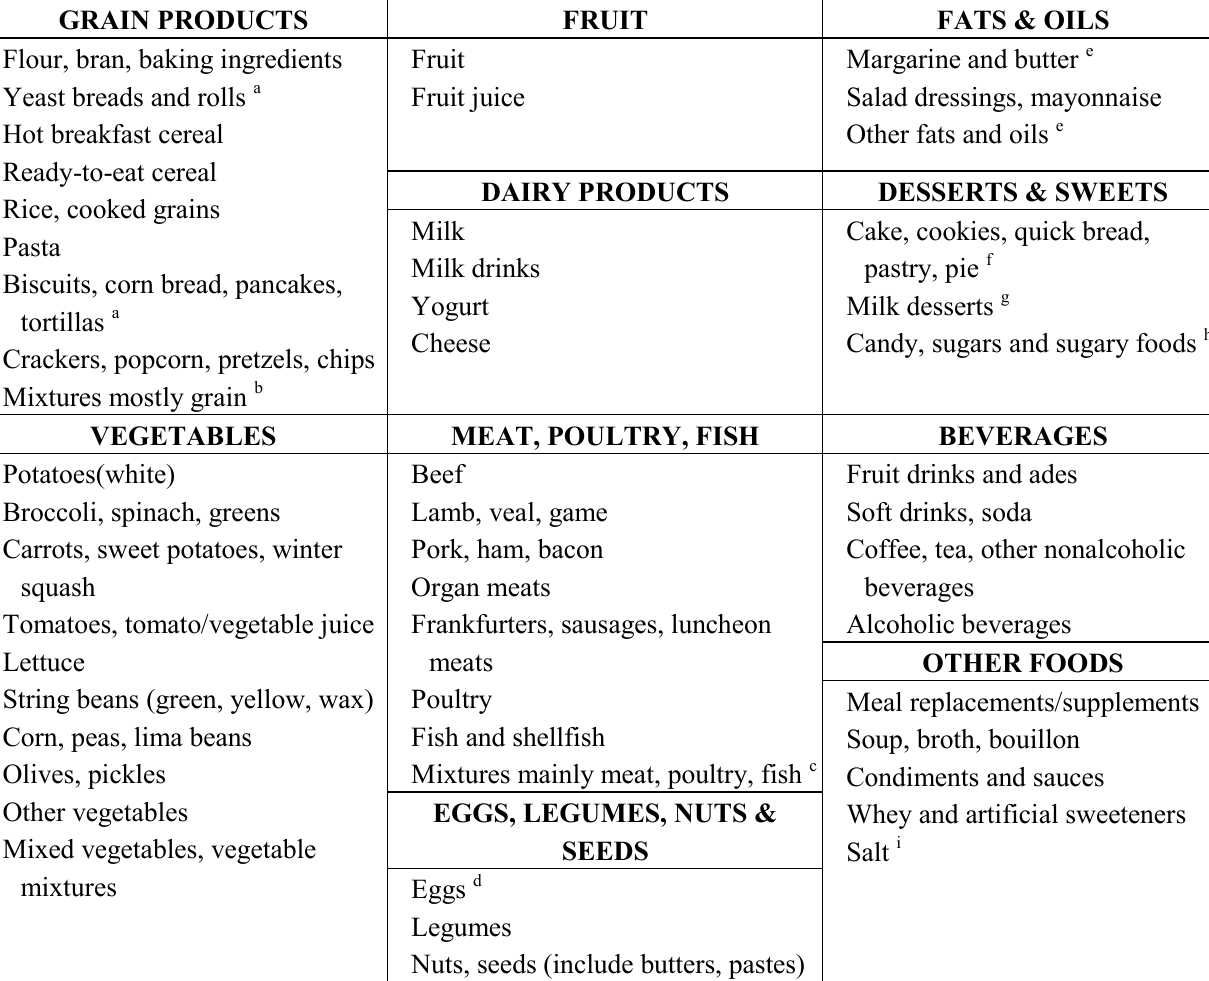
Table 1. Categories of foods for food sources